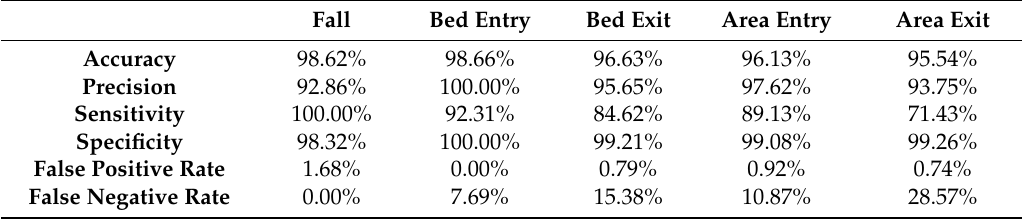
Table 11. Evaluation of